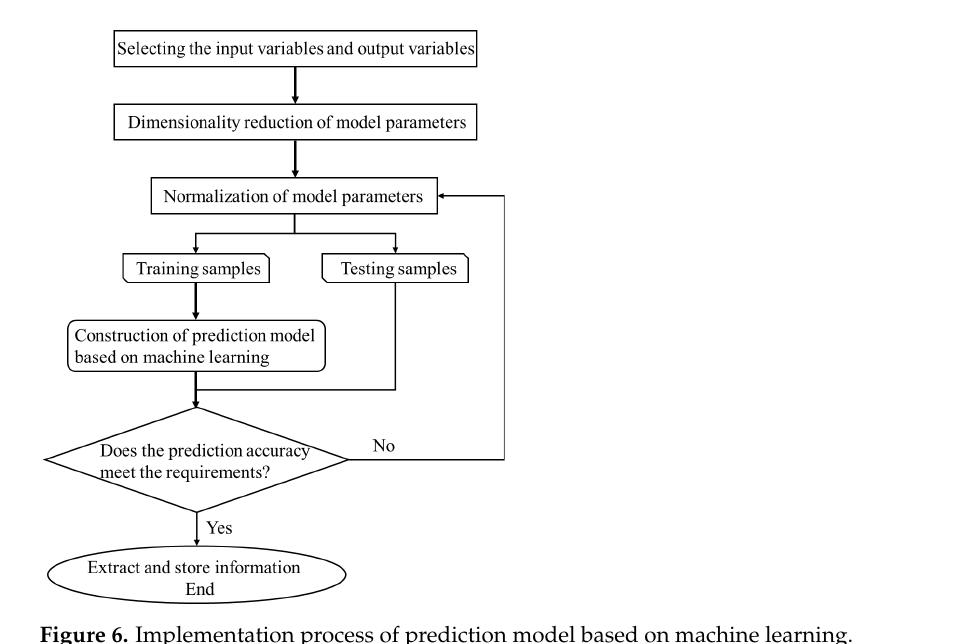
Figure 6. Implementation process of prediction model based on machine learning.